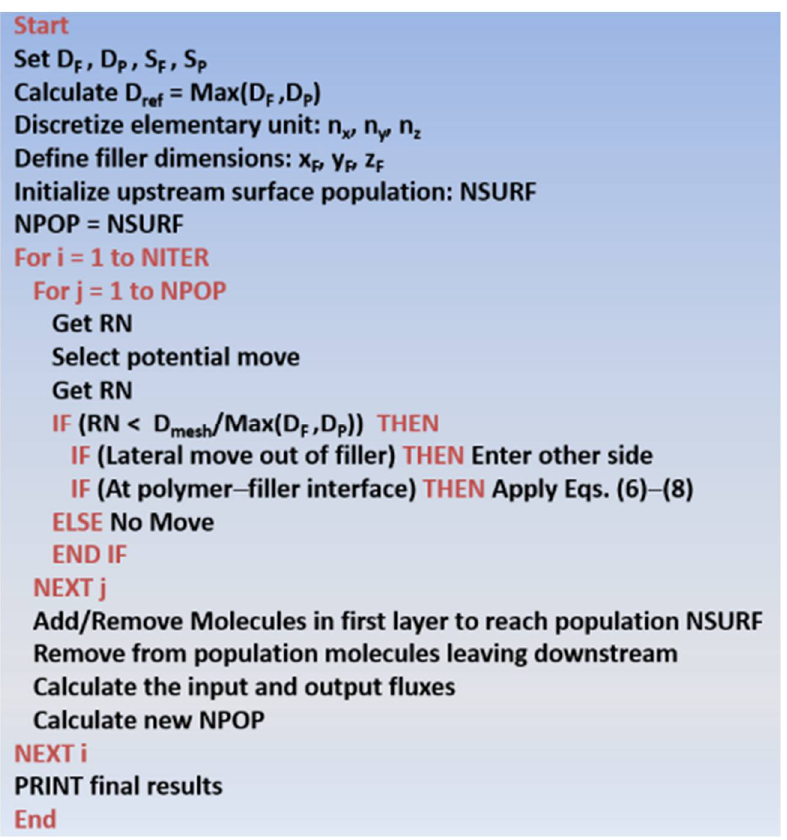
Figure 3. Computer pseudocode of the MC algorithm proposed in this investigation.